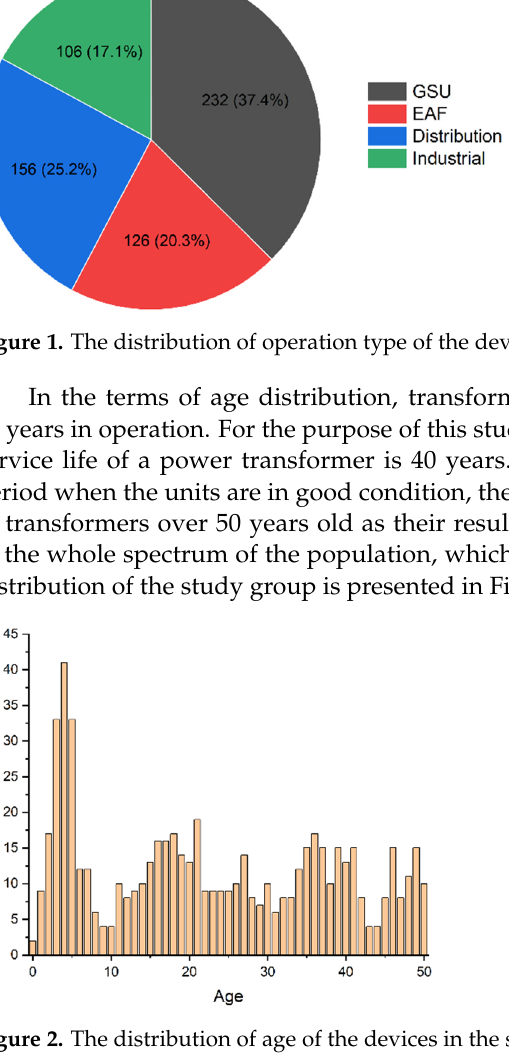
Figure 2. The distribution of age of the devices in the study group.